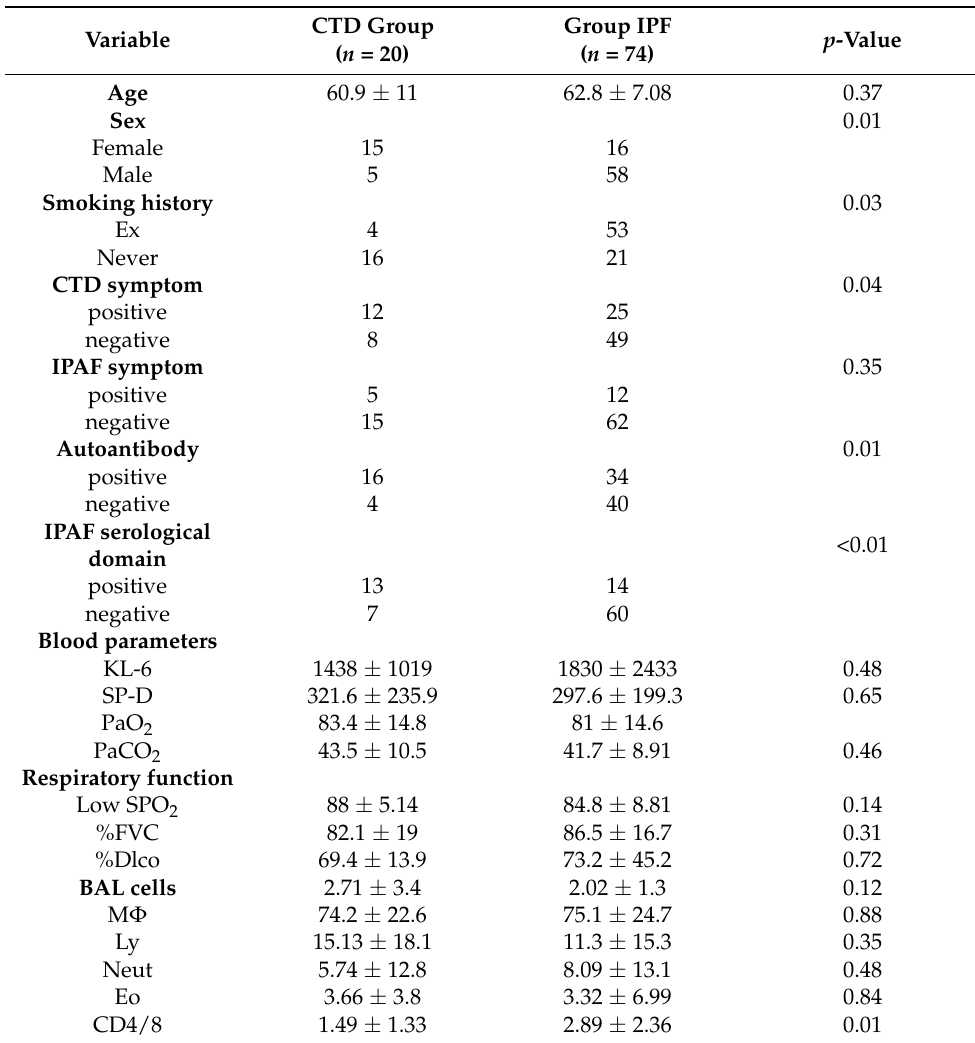
Table 2. Patients’